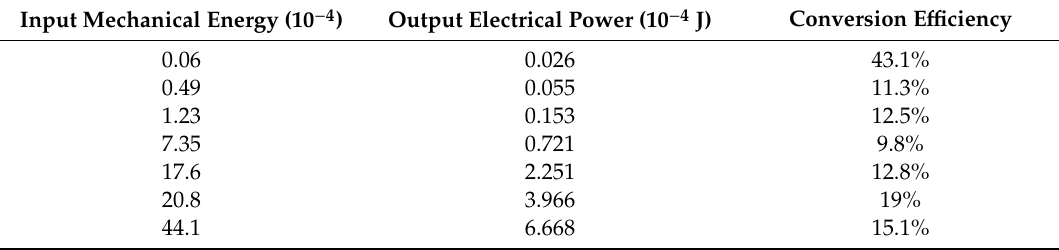
Figure 14. Output energy versus input energy.